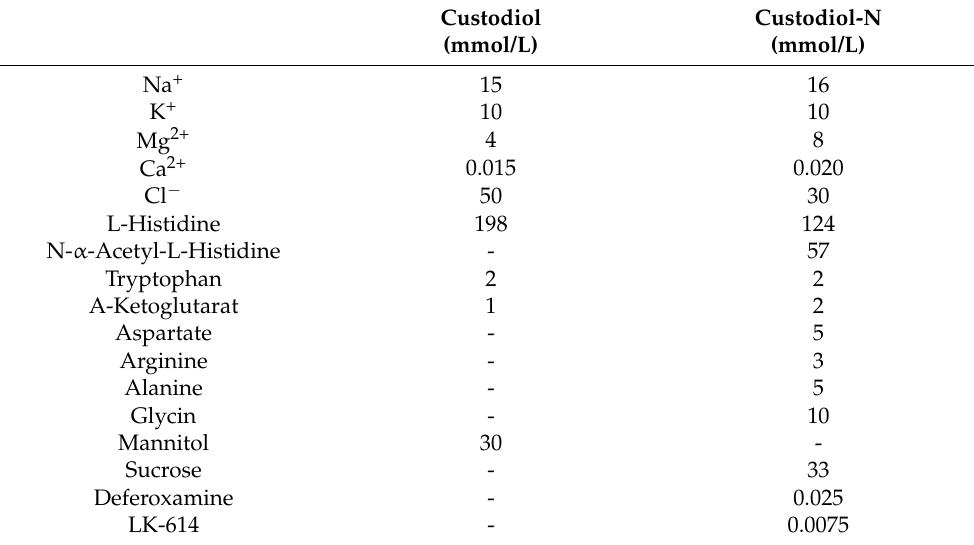
Table 1. Compounds of evaluated cardioplegic